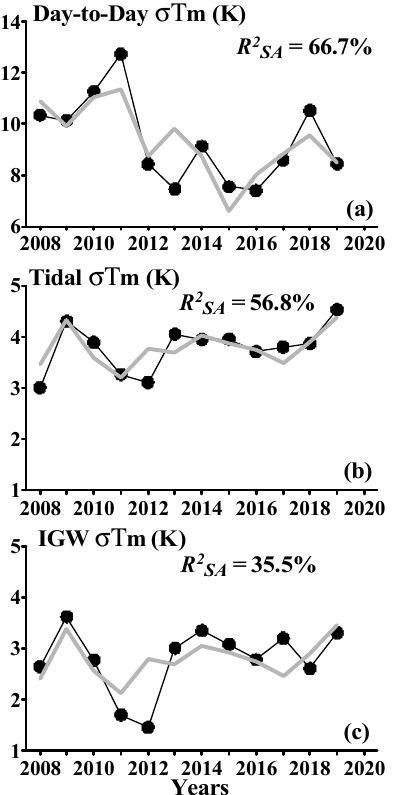
Figure 6. Yearly average SOI values ( left ) and monthly mean SOI values ( right ). El Niño phase is red, and La Niña phase is blue.